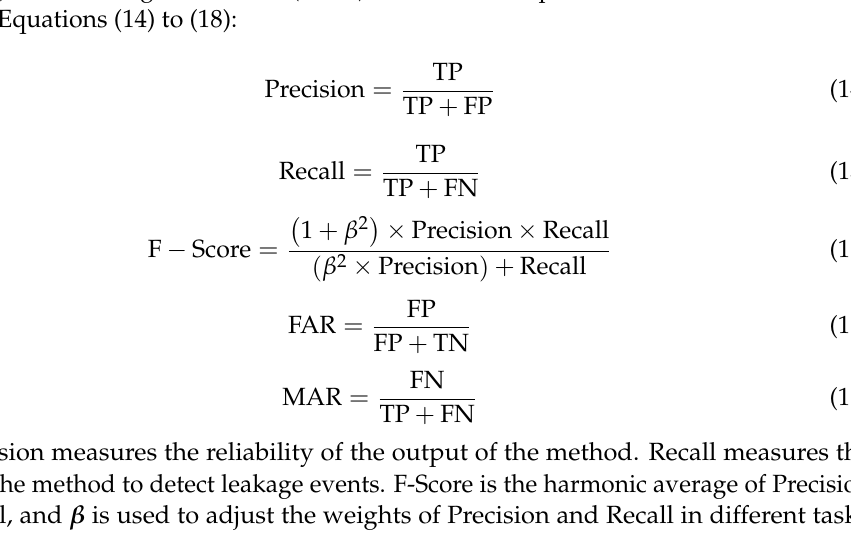
Figure 4. Statistical distribution of the total duration of IC. l in Equations (6) and (7) was taken as 10,000, and cl in Equation (8) was taken as 2000, which indicated that the pressure value of each time point in the time series s 2,p re- flected the average pressure level within 0.4 s around the point p and avoided the influ- ence of the noise. When CWT was performed on time series s 2 ,p , the change in α did not significantly affect the detection of TCs due to the elimination of ICs in the time series s 2 ,p . Considering that the pressure fluctuations caused by variations in water consumption might have an impact on the calculation of the average pressure drop levels caused by leakage events, α was taken as 1000 in the extraction of TCs. 3.3. Results for Two Time Series Data Sets 3.3.1. Leakage Detection Results Figures 5 and 6 show the leakage detection performance of the method on the steady- state time series data set and the water-consumption time series data set under different α ic and α tc , respectively. With increase in α ic and α tc , thr ic and thr tc increase correspond- ingly, the diagnostic criteria for ICs and TCs become stricter, and more background pres-